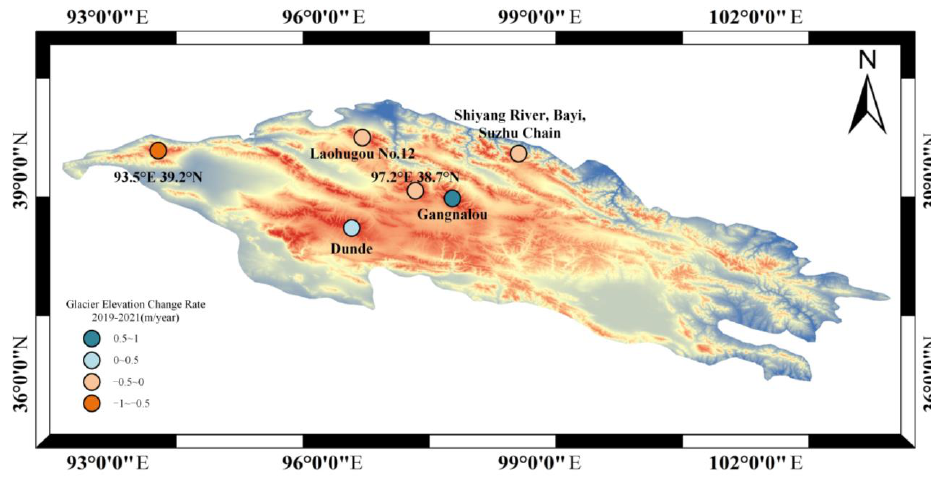
Figure 10. Distribution of annual average change rate of glacier elevation.